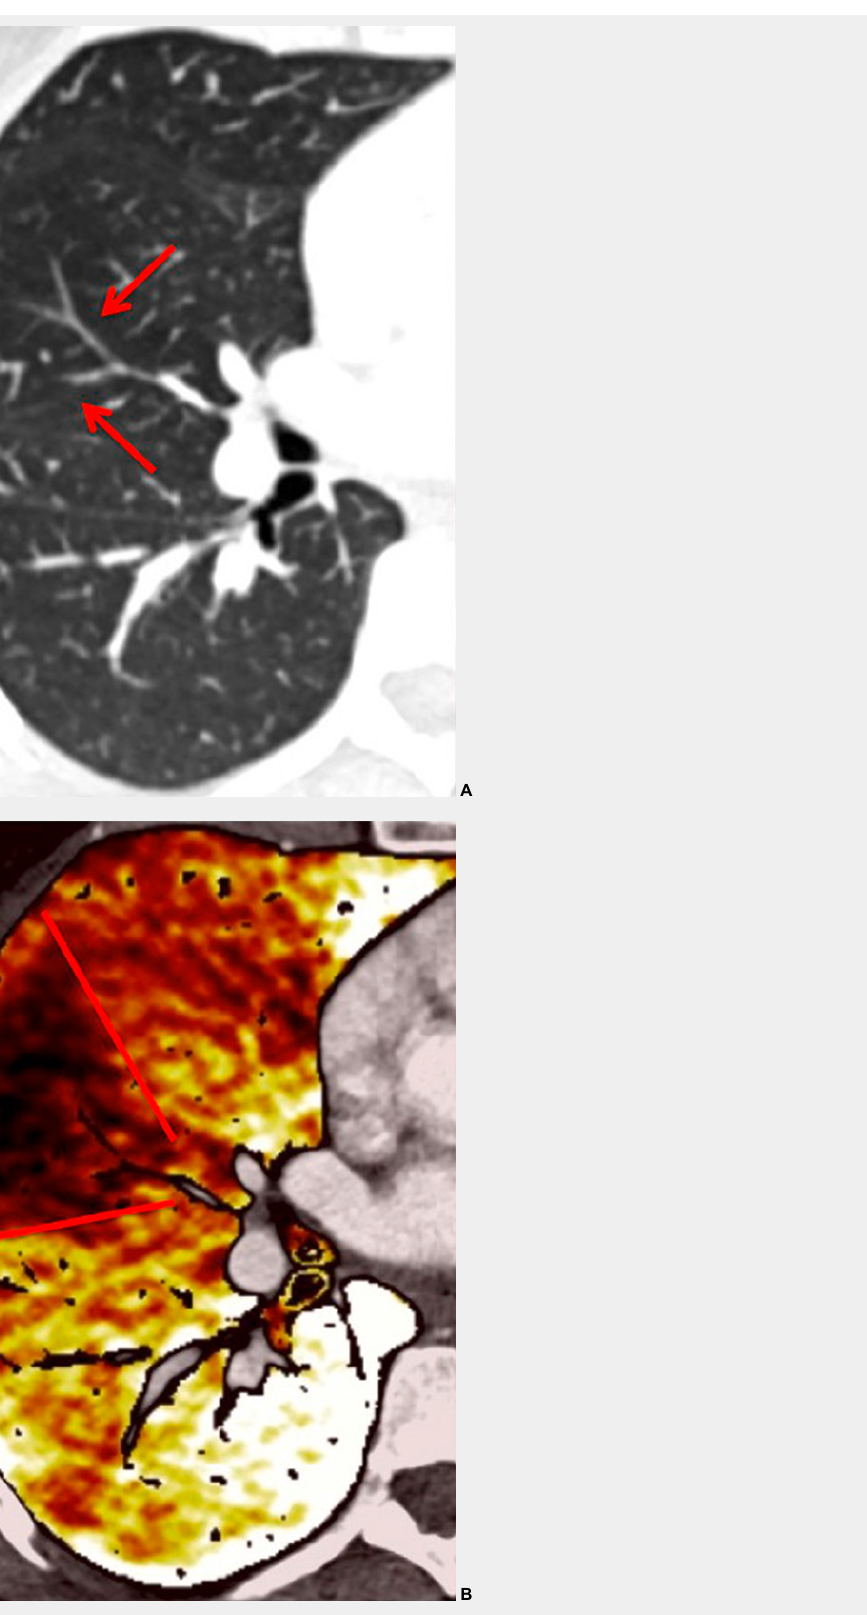
Figure 4 Peripheral chronic thromboembolic pulmonary hypertension (CTEPH). No visible pulmonary artery emboli on standard CTPA are seen (arrows) ( A ) but a wide perfusion defect on the perfusion maps is depicted ( B ) and allows the diagnosis of peripheral